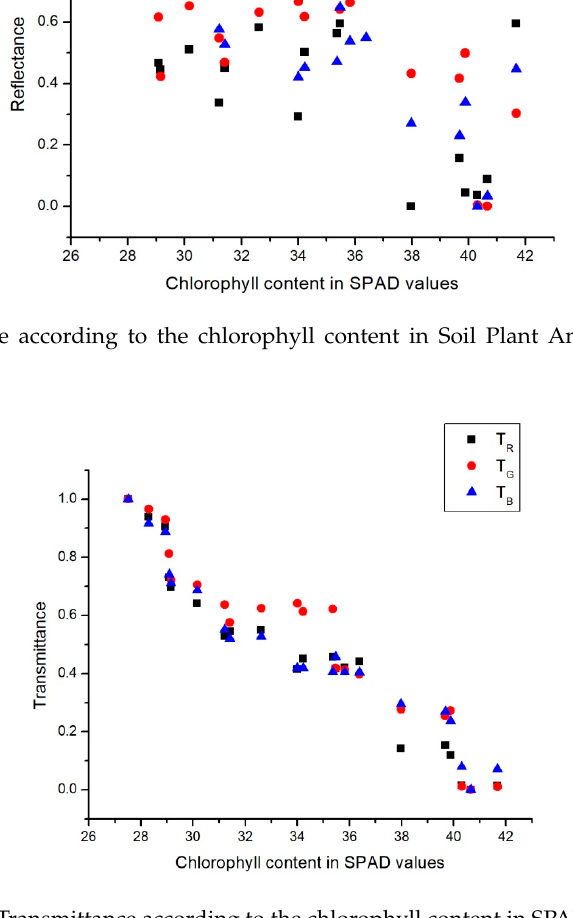
Figure 6. Transmittance according to the chlorophyll content in SPAD